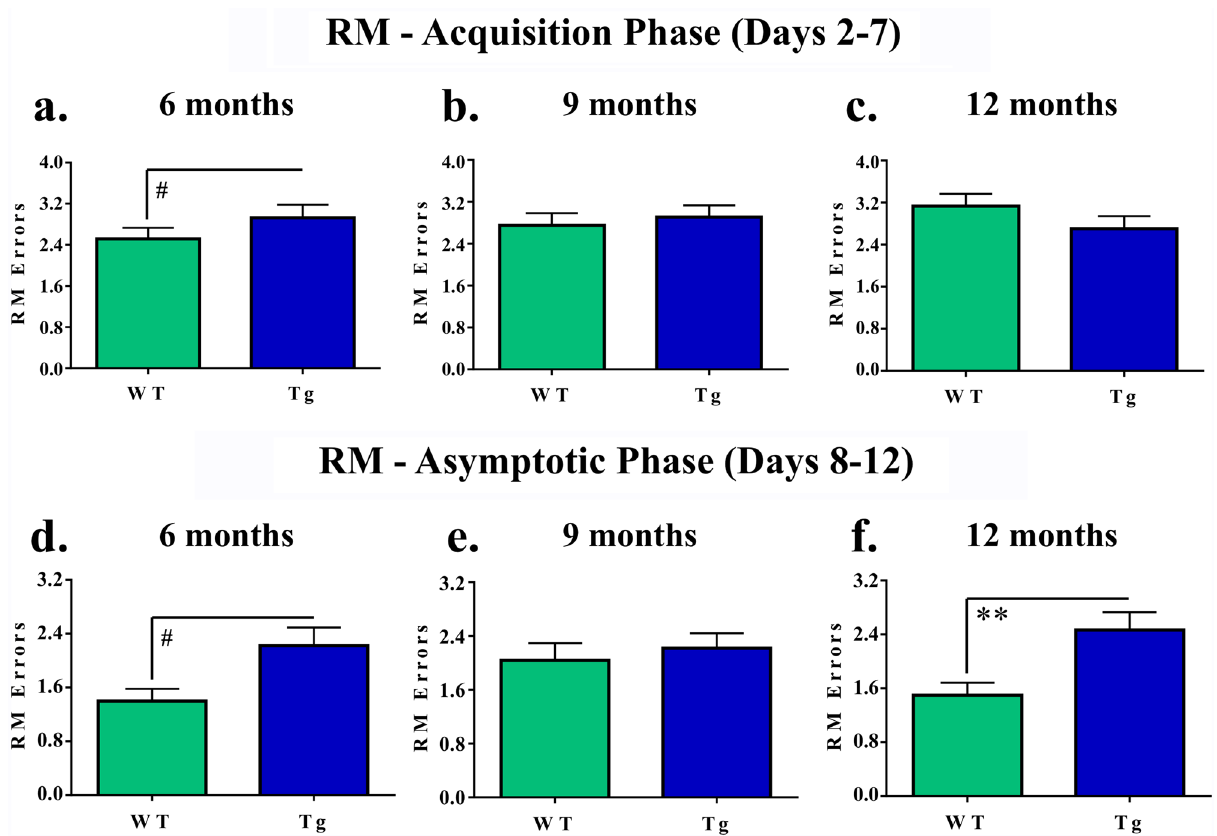
Figure 2. Distinct patterns of reference memory deficits in TgF344-AD rats as evaluated on the WRAM. ( a – c ) During task acquisition, 6-month Tg rats tended to make more errors than their WT counterparts; there were no effects for RM errors in the 9-month or 12-month groups. ( d – f ) During task maintenance, 6-month Tg rats tended to make more errors than their WT counterparts. While there were no differences amongst the 9-month groups, at the 12-month timepoint, Tg rats made significantly more errors than WT rats. # p < 0.10, ** p < counterparts (Fig. 3a). While there were no significant Genotype effects for the 9-month cohort (Fig. 3b), for the 12-month cohort, there was an effect of Genotype [ F (1,17) = 4.90, p = 0.0408], where Tg rats made more WMC errors than WT rats (Fig. 3c). There were no Trial × Genotype interactions for WMC errors across any of the age-specific planned comparisons.